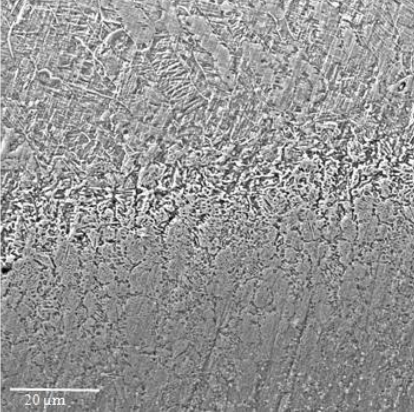
Figure 2. Details of the interface between the base materials and the plasma-deposited layer.